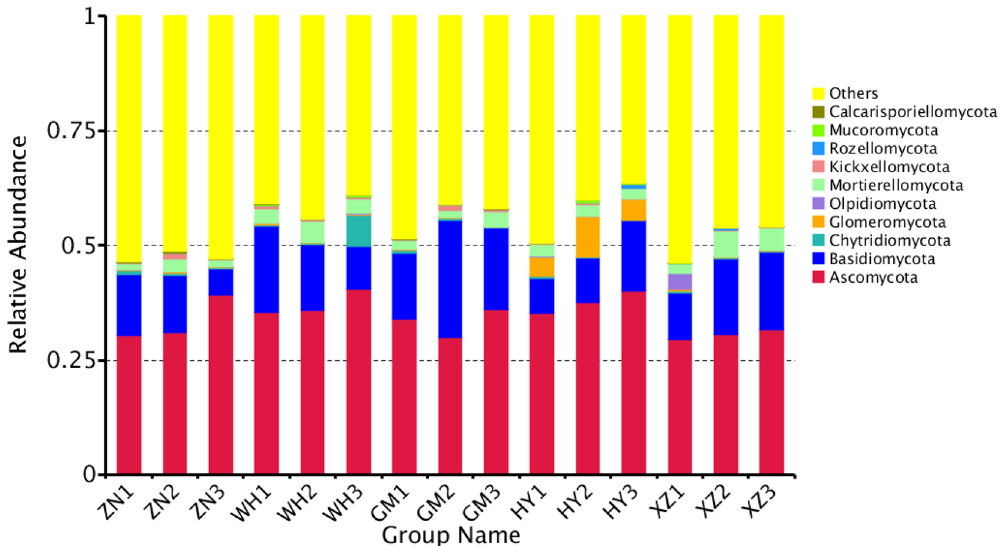
Figure 2. Relative abundance of top 10 fungal